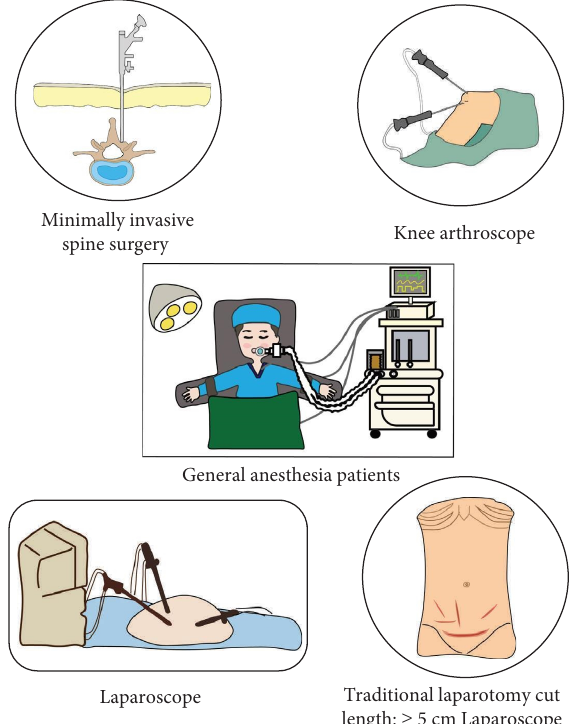
Figure 1: Patients, included in the trial plan, underwent general anesthesia and diferent types of abdominal and orthopedic